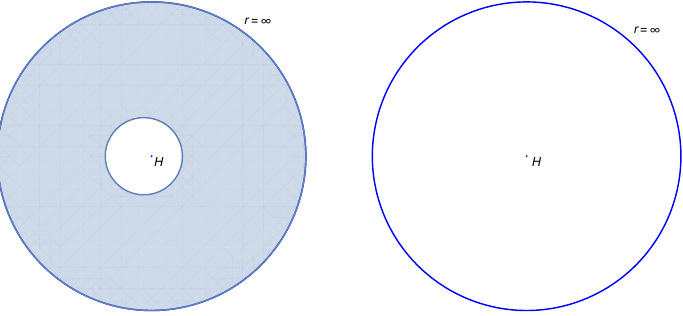
Figure 4 . A degenerate case ( I ) exterior (unshaded region) with AlAdS boundary. Two copies of Euclidean SdS are shown, with an allowed case ( I ) domain wall trajectory shown inside the left copy. The sign of (cid:11) e requires us to discard the shaded region. Gluing the remaining unshaded regions together along the co-dimension 2 horizons ( H ) gives a singular (degenerate) solution analogous to those advocated in